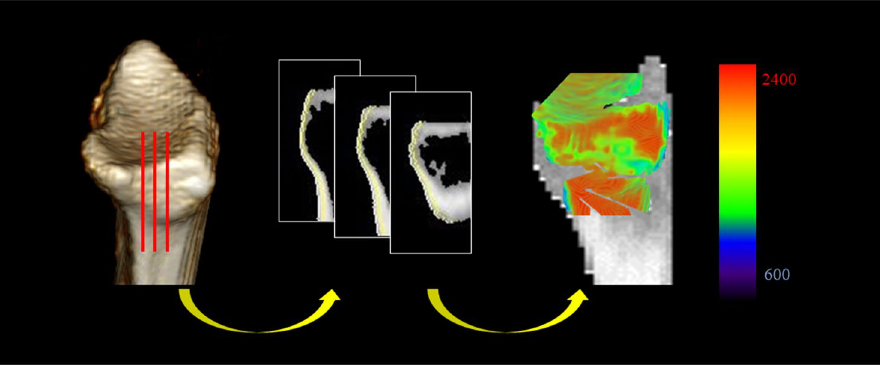
Figure 2. Identification of the subchondral bone regions of the sigmoid notch using customized software. In each coronal slice, X-ray absorption is measured at each coordinate point at 1-mm intervals. The surface- mapping image shows the distribution pattern in the sigmoid notch.